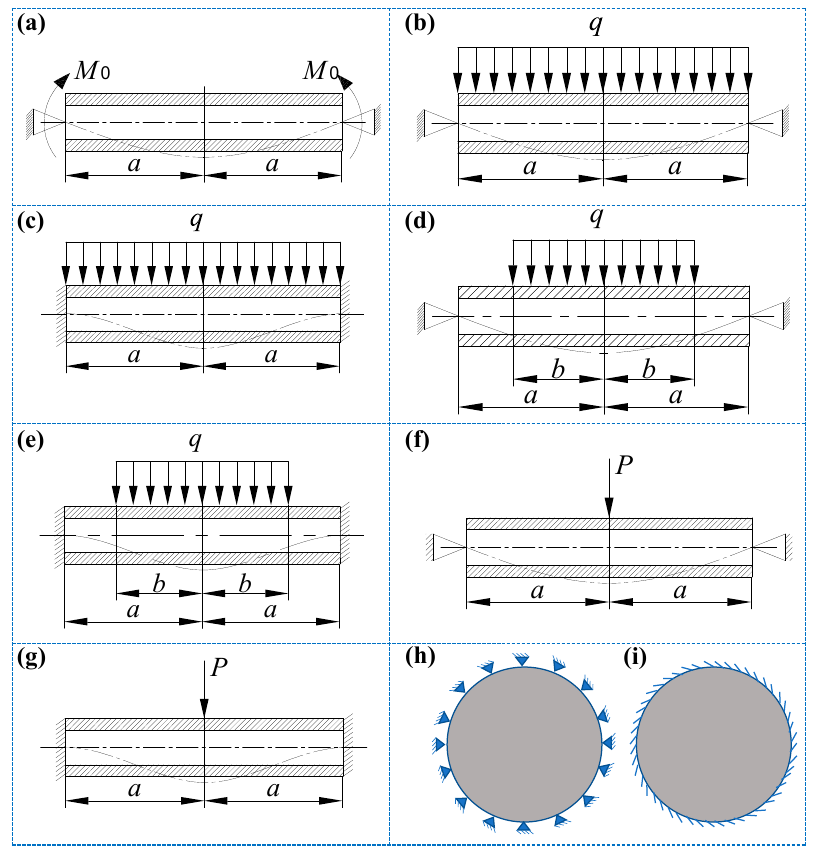
Figure 2. Boundary constraints and loading conditions for circular and non-porous SP-HC. ( a ) Simply supported at the periphery and uniformly distributed bending moment under boundary action; ( b ) simply supported at the periphery, subjected to transverse uniform load; ( c ) fixed-end supported at the periphery, subjected to transverse uniform load; ( d ) simply supported at the periphery, subjected to local transverse uniform load; ( e ) fixed-end supported at the periphery, subject to local transverse uniform load; ( f ) simply supported at the periphery, subject to central concentrated force; ( g ) fixed- end supported at the periphery, subject to central concentrated force; ( h ) the top view of the circular sandwich plate simply supported at its periphery; and ( i ) the top view of the circular sandwich plate fixed-end supported at its